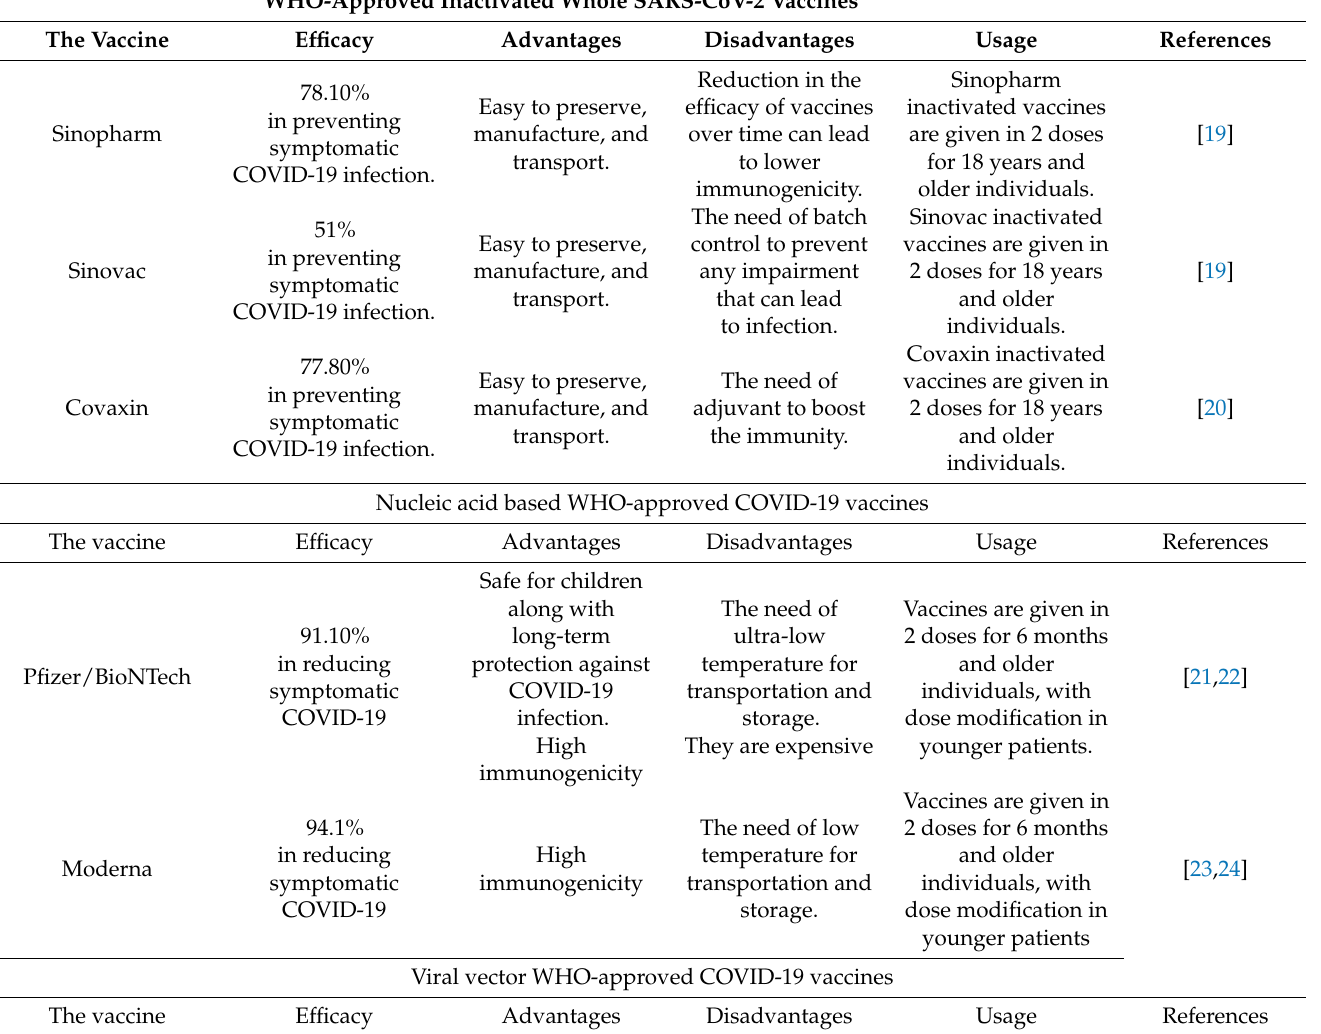
Table 1. WHO-approved